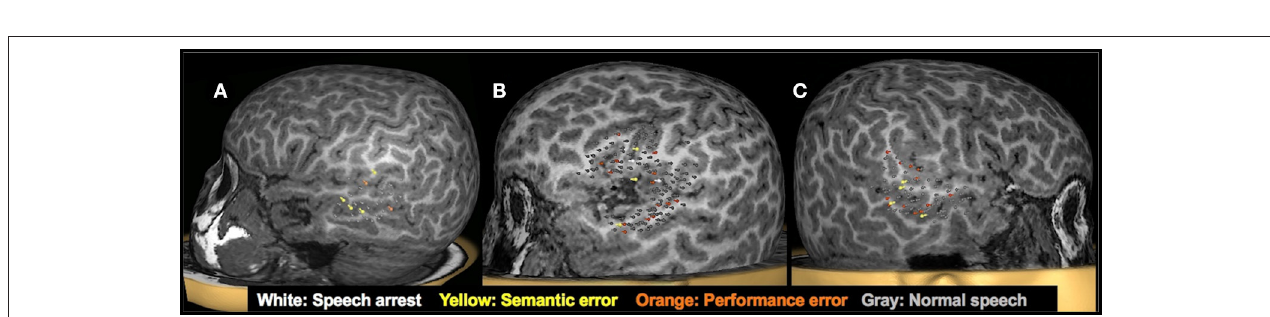
FIGURE 6 | Examples of language mapping with TMS. Speech errors in the form of speech arrest, semantic errors, and performance errors were elicited in both hemispheres. (A) : Language mapping with TMS in a 5.6-year-old female with refractory cryptogenic focal epilepsy and asymptomatic cervical and thoracic syringohydromyelia. Her brain MRI was normal. TMS language mapping was completed using a color naming task and showed bilateral dominance for expressive language. (B) : Language mapping with TMS in a 5.6-year-old male with right parietal cortical dysplasia that was in the inferior parietal lobule, predominantly superior to the marginal gyrus. TMS language mapping was completed using an object naming task and indicated a right hemisphere dominance for expressive language.